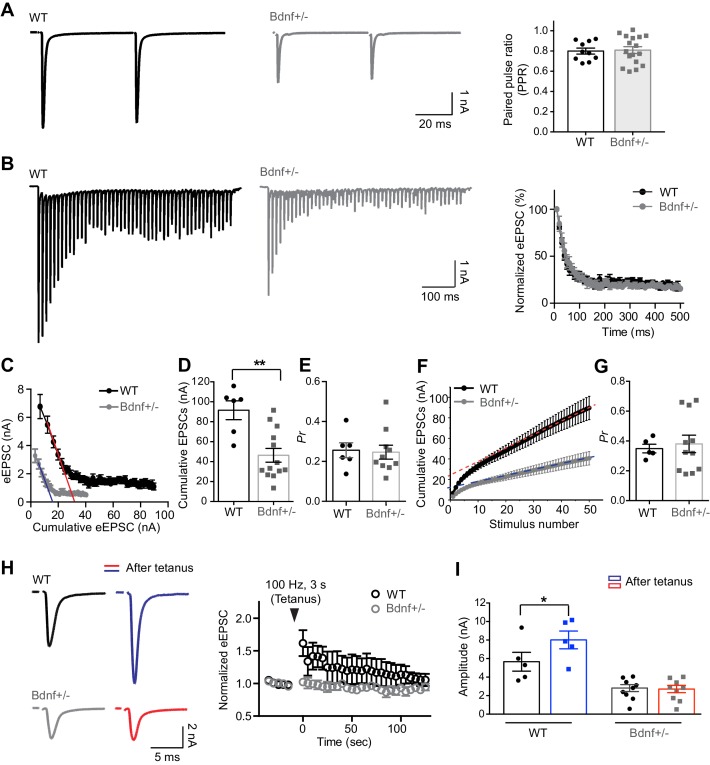
Reduction in endogenous BDNF alters presynaptic properties at the calyx terminals.(A) Representative traces of EPSCs evoked by paired-pulse stimulation from WT (black) and Bdnf+/– (gray) mice (at P16, left). Summary of the PPR (right). (B) Trains of eEPSCs at 100 Hz stimulation in WT (black) and Bdnf+/– (gray) mice (left). Normalized amplitude of eEPSCs relative to the first eEPSC amplitude in WT and Bdnf+/– mice (right). (C) Plot of eEPSC amplitudes against the amplitude of the cumulative eEPSC in WT and Bdnf+/– mice. Plots were linearly fitted from the second through the fourth cumulative eEPSCs (red line for WT and blue line for Bdnf+/–), which were estimated by back-extrapolated linear fits to the x axis to estimate the RRP. (D, E) Summary of the cumulative eEPSC size and the release probability (Pr) using the EQ method in WT and Bdnf+/– mice. (F) Plot of the cumulative eEPSC against stimulus number in WT and Bdnf+/– mice. A line fit to the steady-state points is back-extrapolated to the y-axis to estimate the RRP. (G) Summary of the release probability (Pr) using the SMN method in WT and Bdnf+/– mice. (H) Left, EPSCs evoked at 30 s before and after tetanic stimulation (100 Hz, 3 s) from WT (top) and Bdnf+/– (bottom) mice. Right, plot of normalized eEPSC amplitude after the tetanus relative to the eEPSC amplitude before the tetanus. (I) Summary of the amplitude of eEPSCs before and after the tetanus from WT and Bdnf+/– mice. Data are shown as the mean ± s.e.m. *p<0.05; **p<0.01 (unpaired t-test; paired t-test).